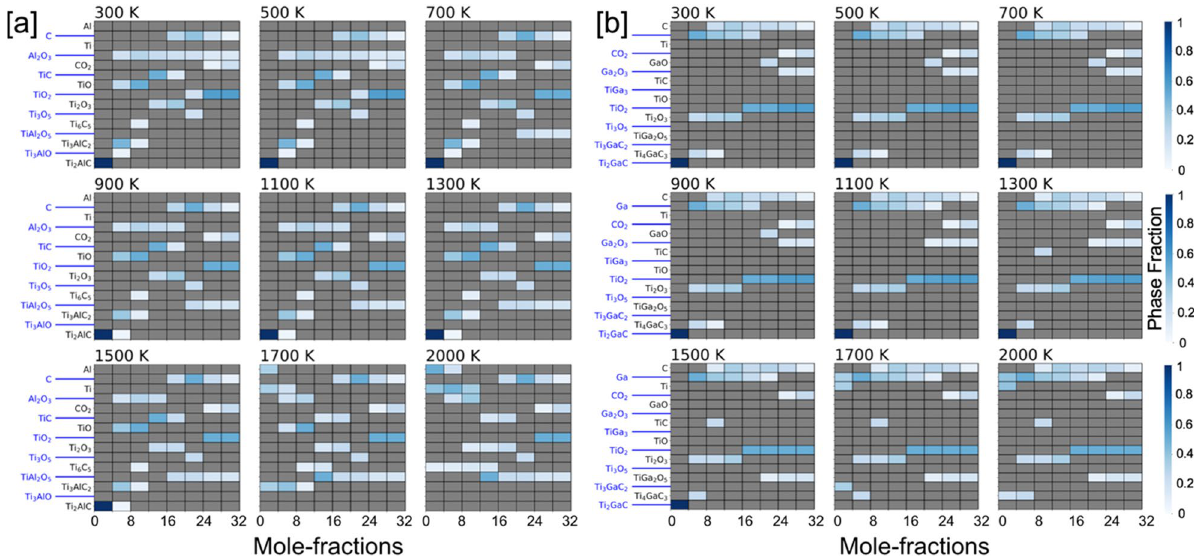
Figure 5. Phase fractions of ( a ) [Ti 2 AlC + O 2 ] and ( b ) [Ti 2 GaC + O 2 ] reaction products at different temperatures with increasing temperature from 300 to 2000 K with respect to molar percent oxygen (0–32 mol). The color gradient (shades of blue) shows molar phase fractions. Blank spot [gray (0)] suggests no